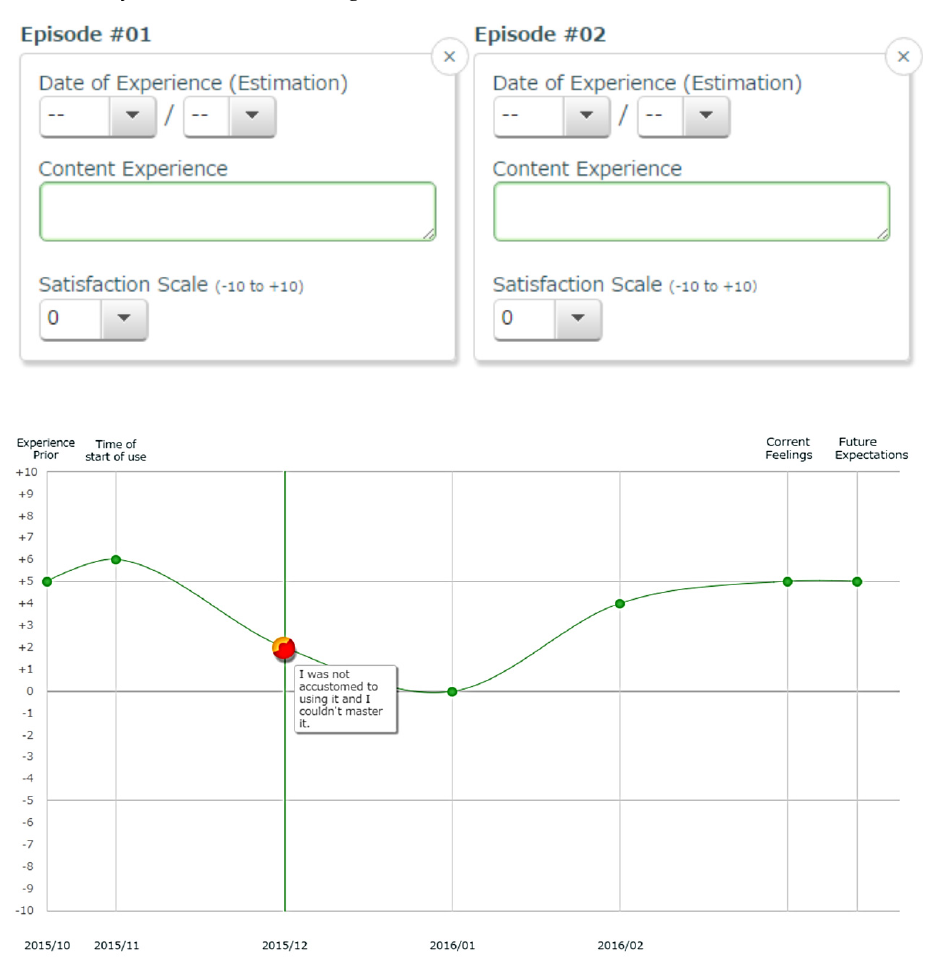
Figure 3. Users enter episodes comprised of their experience and satisfaction rating, and a UX graph showing these episodes is generated.